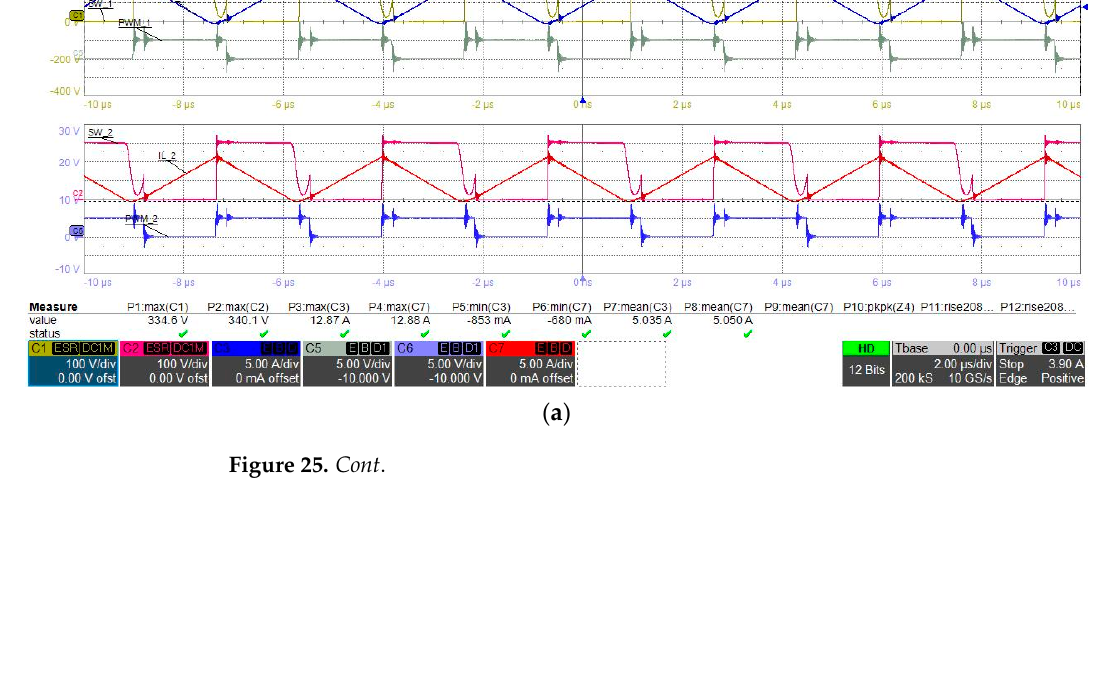
( b ) Figure 25. Waveforms for P OUT = 1.5 kW. ( a ) Main waveforms (yellow and purple traces are, respec- tively, the V DS of the two power devices, red and blue traces are the inductors currents, grey and light blue traces represent the two driving PWM signals; ( b ) magnification of a single period. Figure 26a,b show the measurements of the V DS ringing frequency and overshoot am- plitude, being equal to 65.8 MHz and 34 V (11% overshoot), respectively. From the fre- quency measurement, considering an output capacitance in the tens of nF range, the PCB stray inductance order of magnitude is tens of nH.